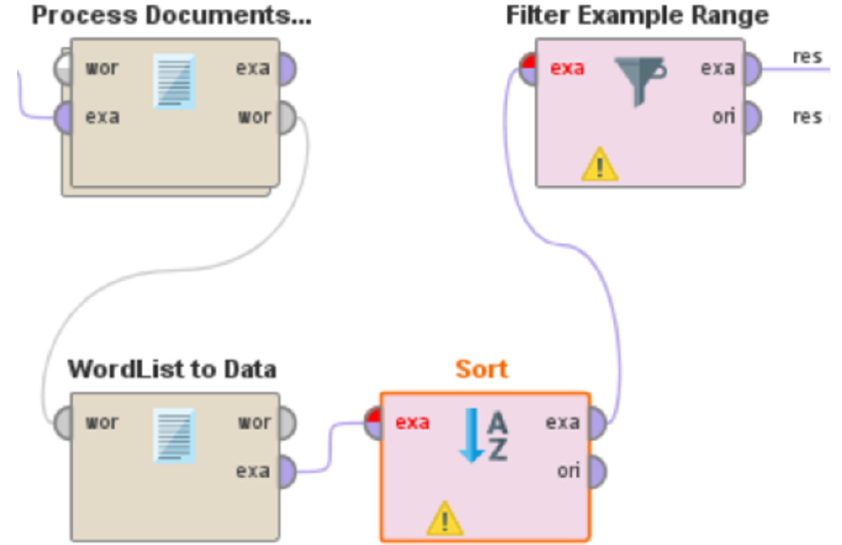
Figure 9. Word cloud stemming.